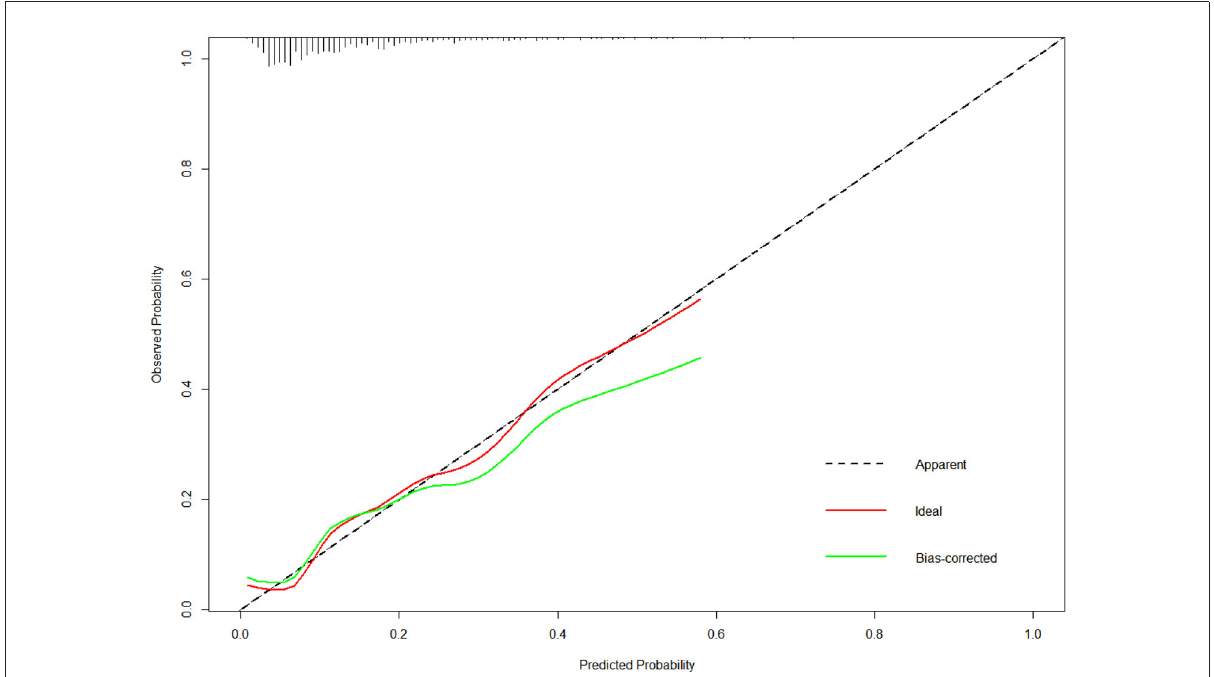
FIGURE3 The calibration curves of the nomogram. The x-axis represents the predicted risk of HIV infection. The y-axis represents the actual diagnosed HIV incidence. The diagonal dotted line represents a perfect prediction by an ideal model. The green line represents the performance of the nomogram, of which a closer fit to the diagonal dotted line represents a better